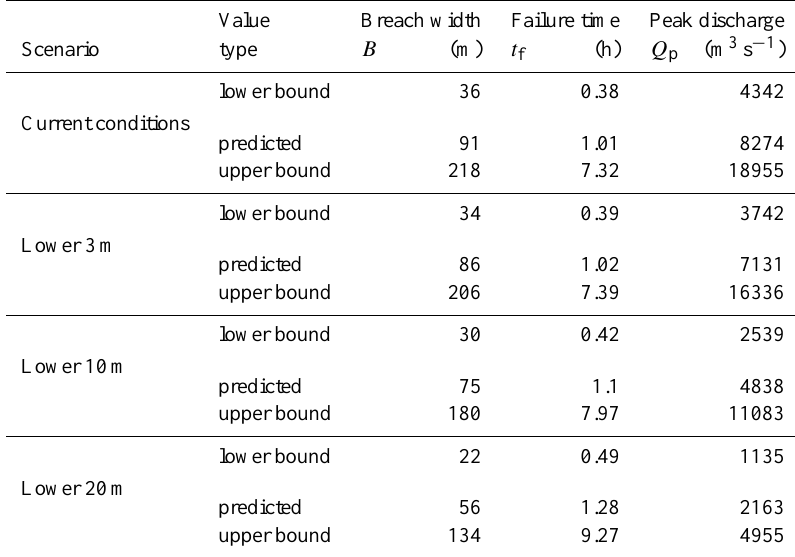
Table 4. Inundation model expected values and uncertainty bands at Imja Tsho, Dingboche and Phakding for current lake conditions.